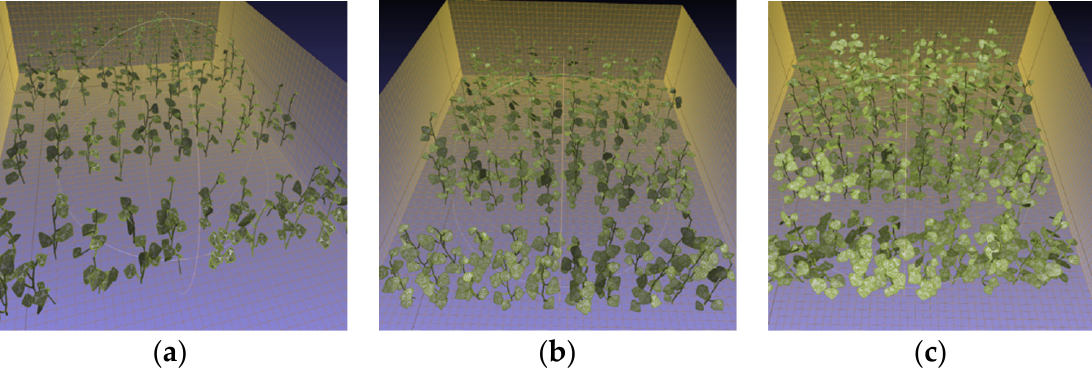
Figure A3. The preview of three virtual canopies (n = 80) with different leaf sizes. ( a ) small leaf; ( b ) medium leaf; ( c ) big leaf.